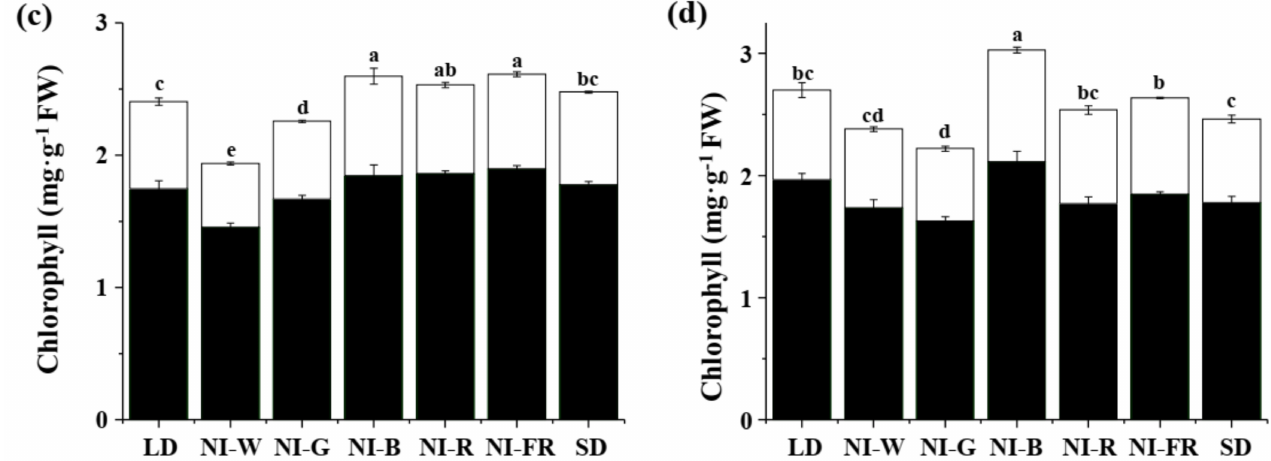
Figure 4. Chlorophyll contents as affected by photoperiod and quality of night interruption (NI) light: ( a , b ), the effect of photoperiod on chlorophyll contents in ‘Sulhyang’ and ‘Maehyang’, respectively; ( c , d ), the effect of NI light on chlorophyll contents in ‘Sulhyang’ and ‘Maehyang’, respectively: LD, long day; SD, short day; W, white; G, green; B, blue; R, red; and FR, far-red. Lowercase letters indicate significant difference according to the Duncan’s multiple range test at a 0.05 level. Vertical bars indicate standard errors.